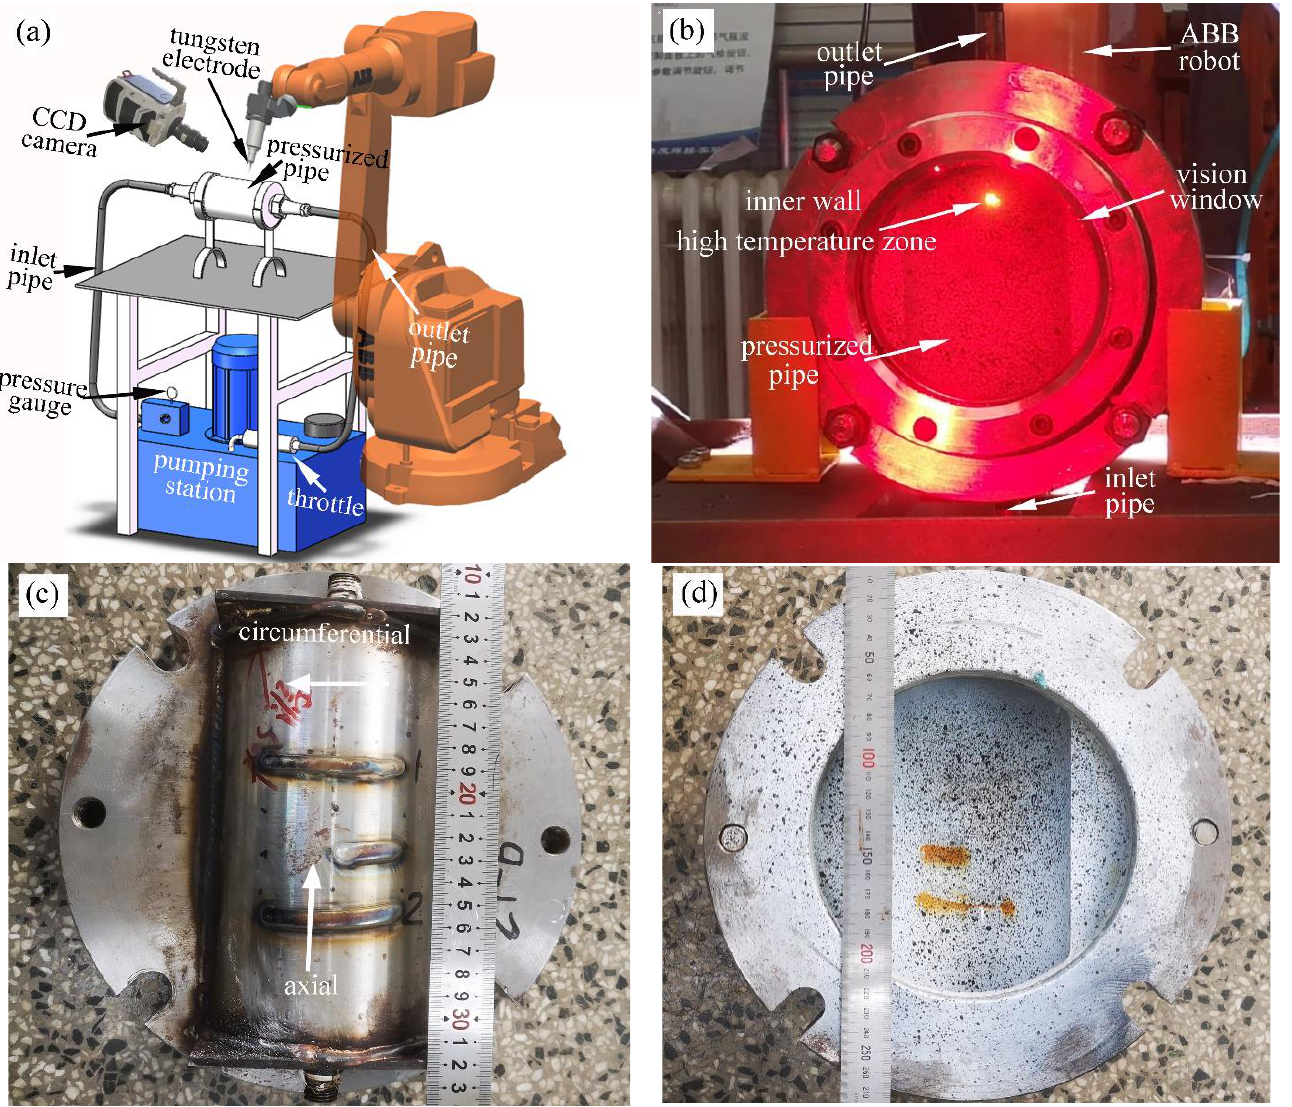
Figure 1. In-service welding device: ( a ) external observation device; ( b ) internal observation device; ( c ) top view of half-pipe set-up; ( d ) bottom view of half-pipe set-up.